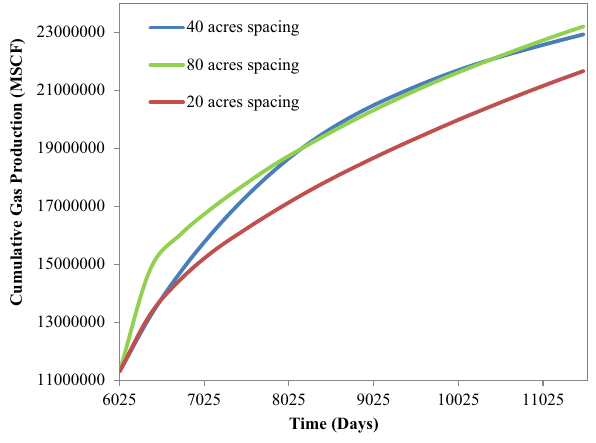
Fig. 12 Cumulative gas production versus time for 3 vertical infill wells at different well spacings